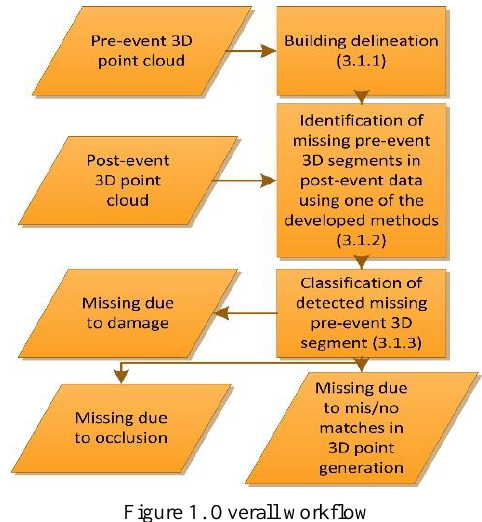
Figure 1. Overall